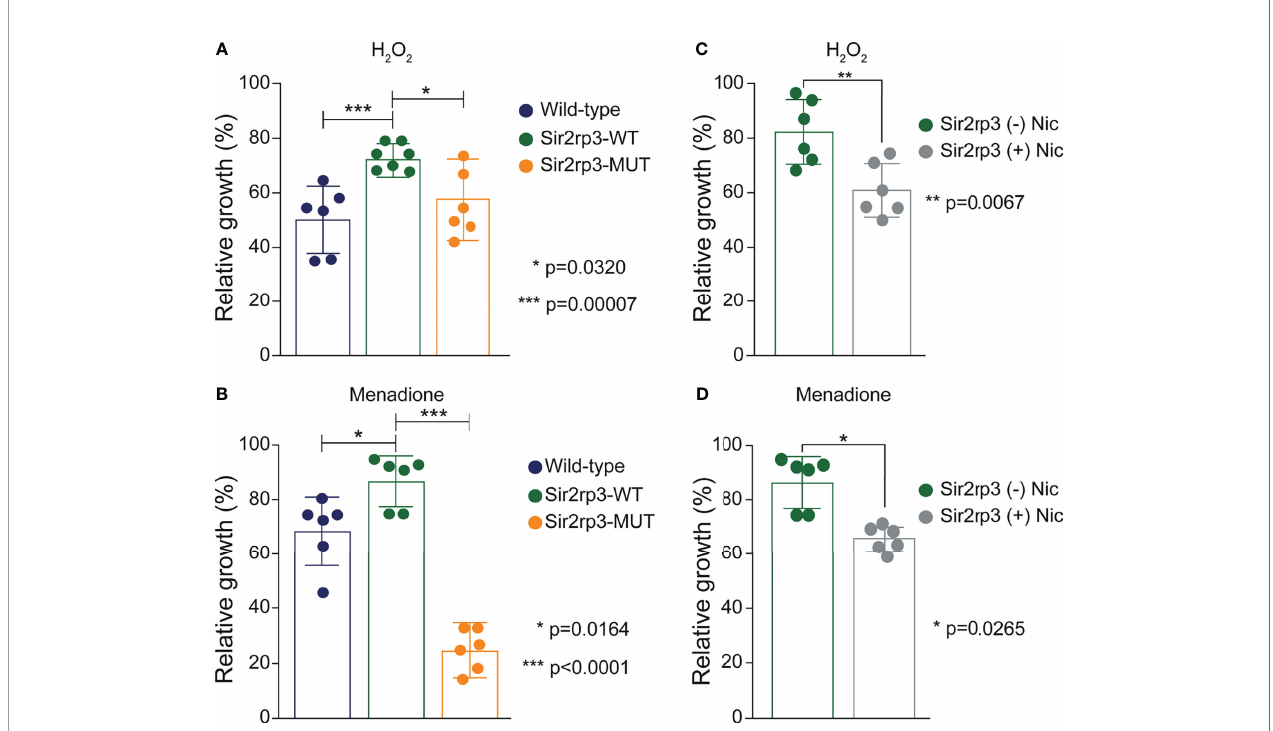
FIGURE 1 | Overexpression of mitochondrial TcSir2rp3 improves parasite recovery after oxidative stress. (A, B) Epimastigote forms of WT (blue bars), Sir2rp3-WT (green bars), and Sir2rp3-MUT (orange bars) were submitted to oxidative stress with 100 µM H 2 O 2 and 10 µM menadione and recovering was quanti fi ed. (C, D) Sir2rp3-WT (green bars) recovery was analyzed in the assays performed in the presence of nicotinamide (Nic) (grey bars) compared with assays performed without the inhibitor (orange bars). All experiments were performed in triplicate. Statistical analyzes were performed using the Student ’ s t -test. * p = 0.0320; *** p = 0.00007 in (A) ; ** p = 0.0067 in (B) ; * p = 0.00164 and *** p < 0.0001 in (C) ; * p = 0.0265 in (D)